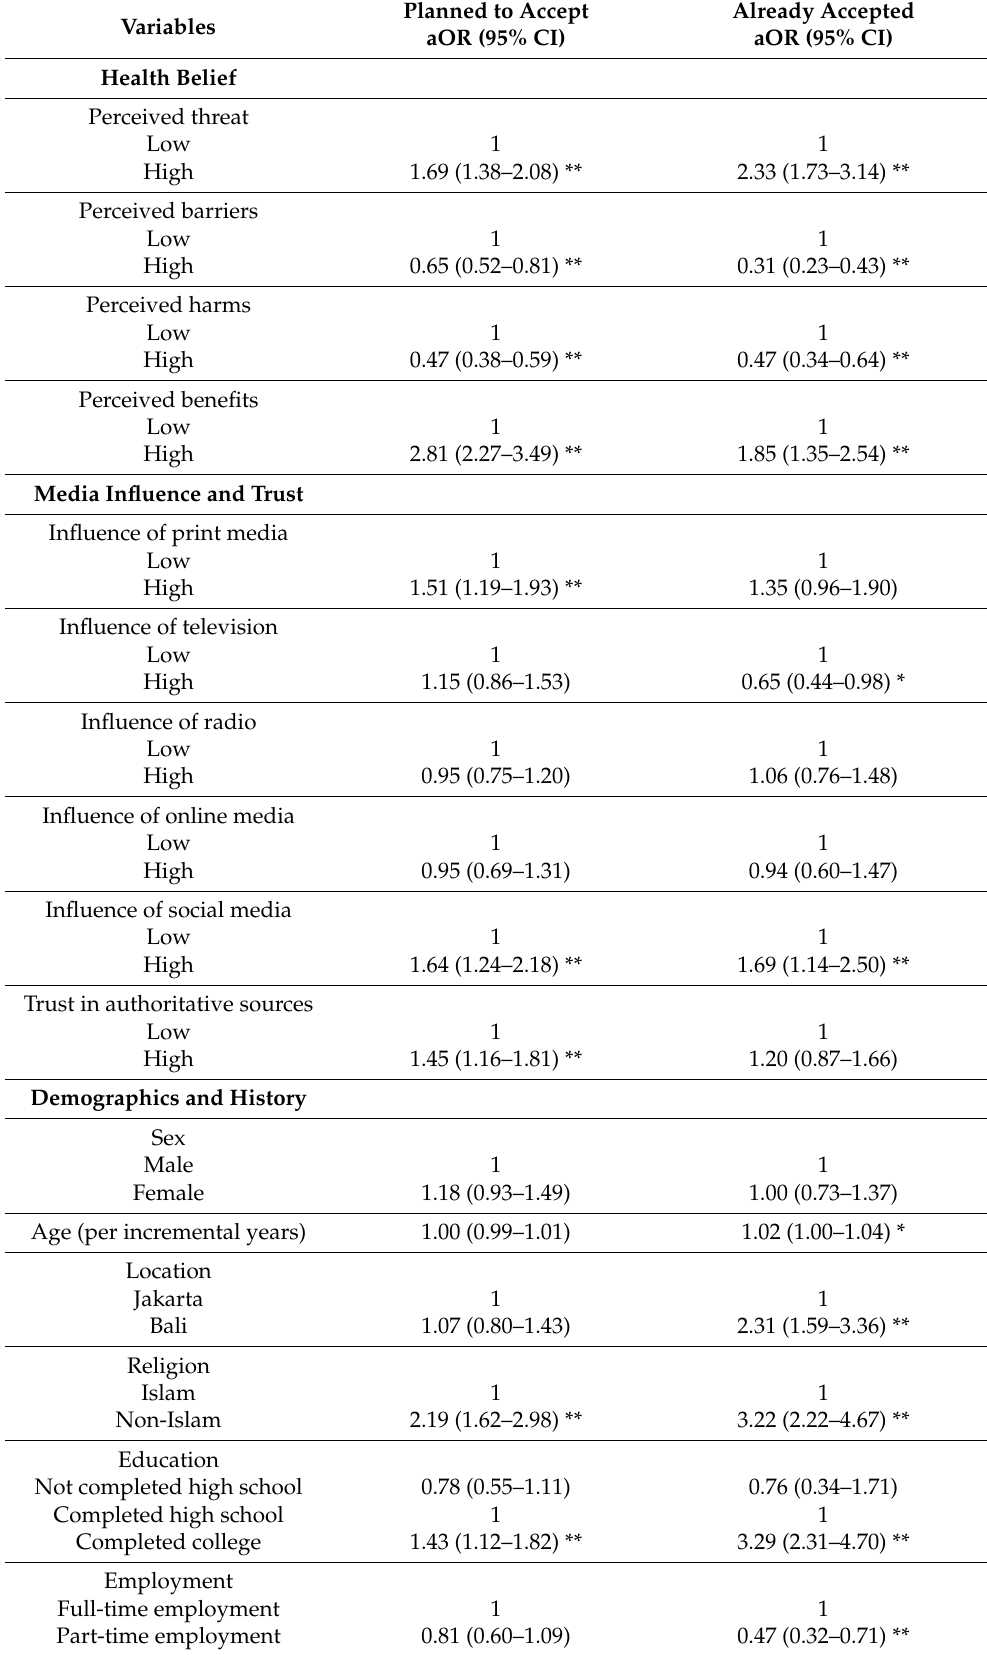
Table 3. Multinomial logistic regression model for COVID-19 vaccine booster